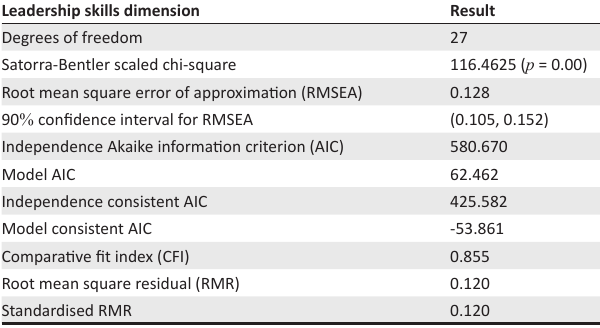
TABLE 2 : Goodness of fit statistics for the 1D measurement model.